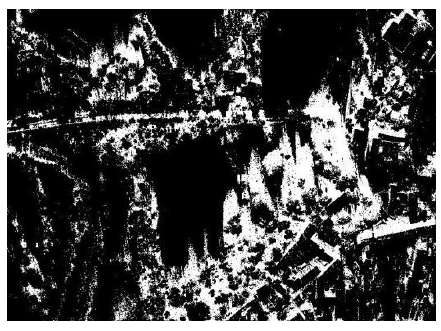
Figure 1: Original image classificated respectively with Maximum Likelihood (ML), K-Means (KM) and Self Organized Map(SOM)